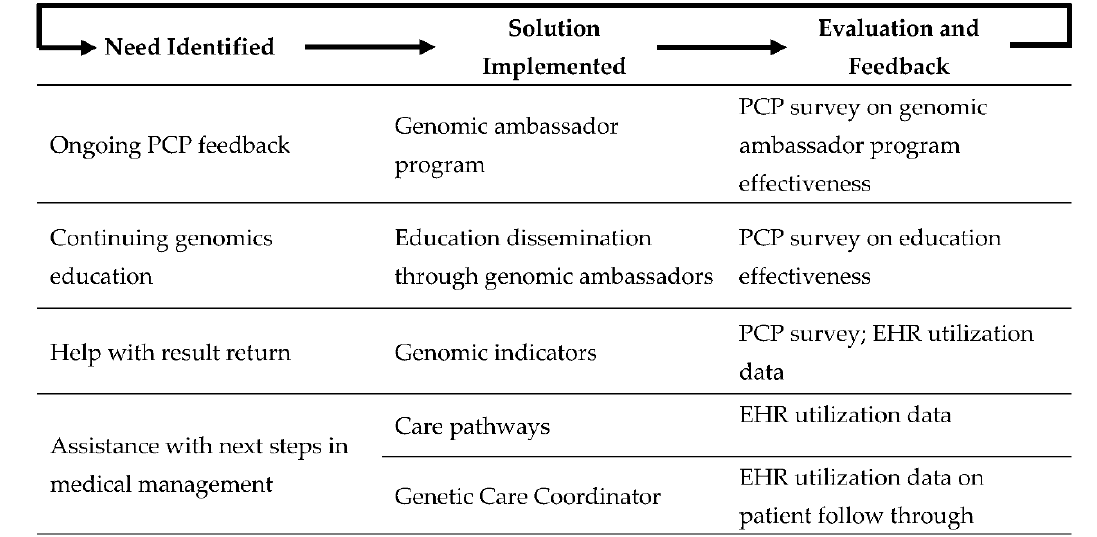
Figure 3. Continuous process improvement plan.